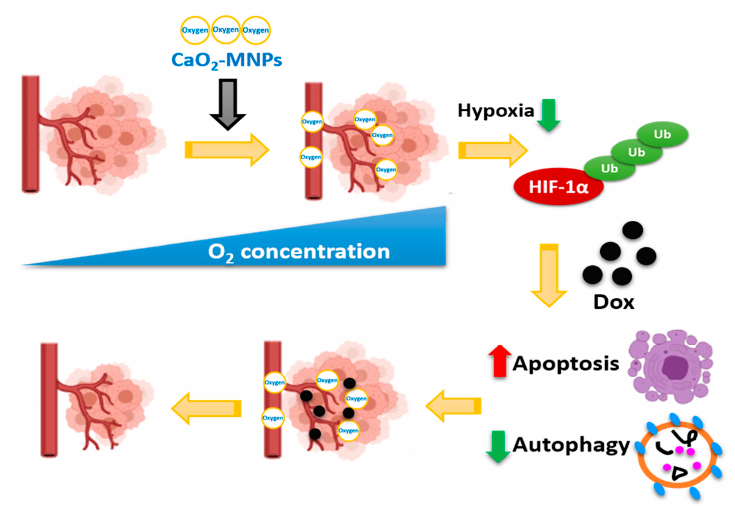
Figure 7. CaO 2 -MNPs attenuate hypoxia-induced chemoresistance in TNBC. CaO 2 -MNPs release oxygen and degrade HIF-1 α protein by ubiquitination. Hypoxia inhibit the DOX-induced apopto- sis and DOX-increased autophagy in TNBC cells. CaO 2 -MNPs promote cell death